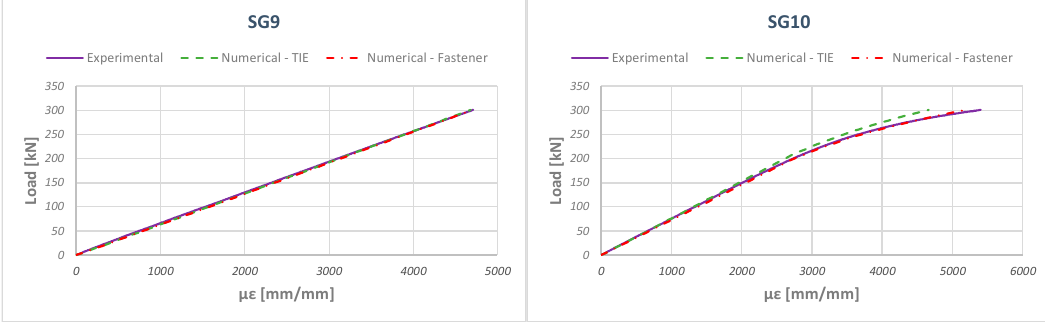
Figure 16. Numerical–experimental comparisons for SG-9 and SG-10: numerical TIE and Fasteners